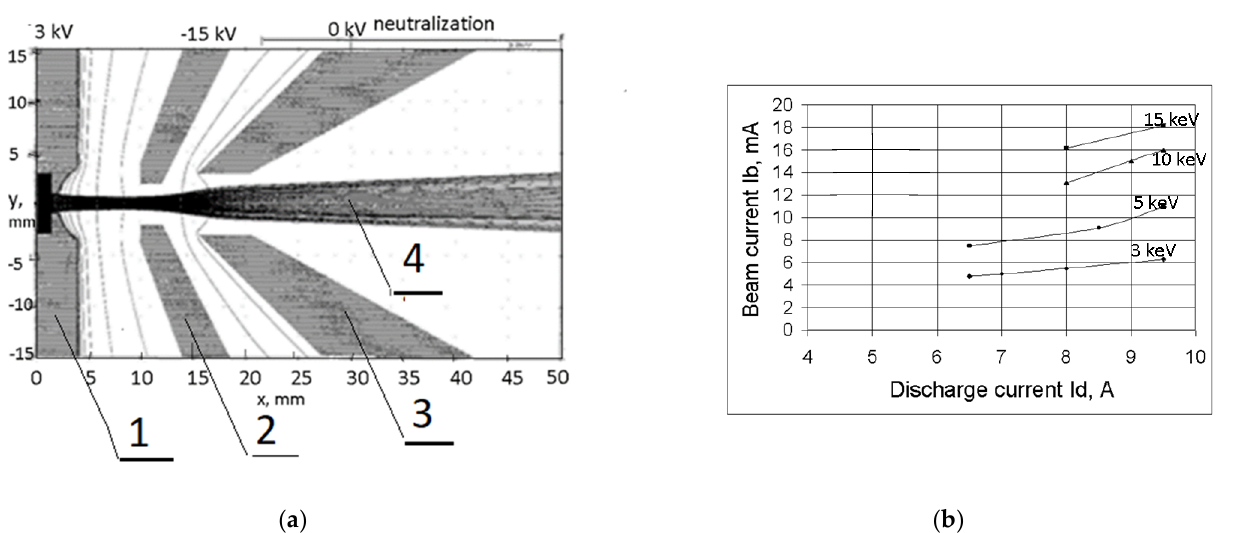
Figure 2. ( a ) Schematic of the extraction system of our small anode low energy ion source, 1—plasma electrode, 2—suppressor electrode, 3—ground electrode, 4—ion beam. ( b ) Dependence of analyzed 11 B + beam current on discharge current at different beam energies.